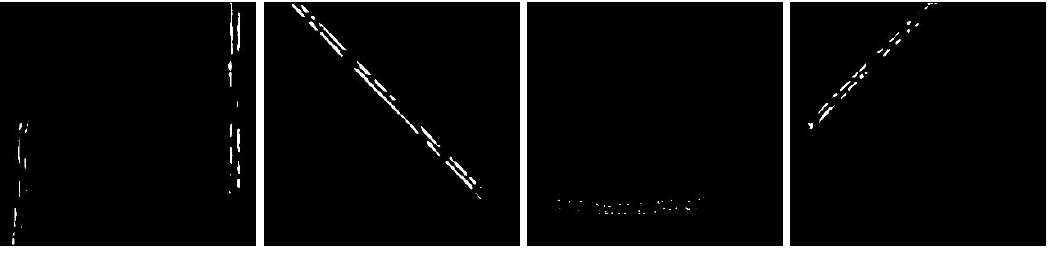
Figure 3. Labels of tonal features